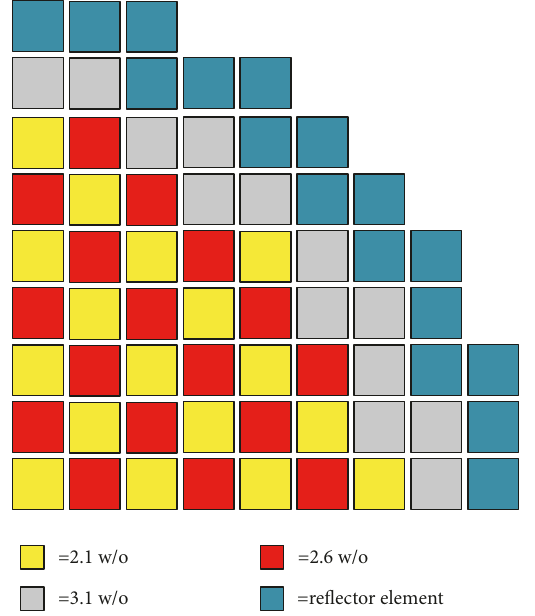
Figure 2: A symmetrical core configuration for 2nd axial layer [9].